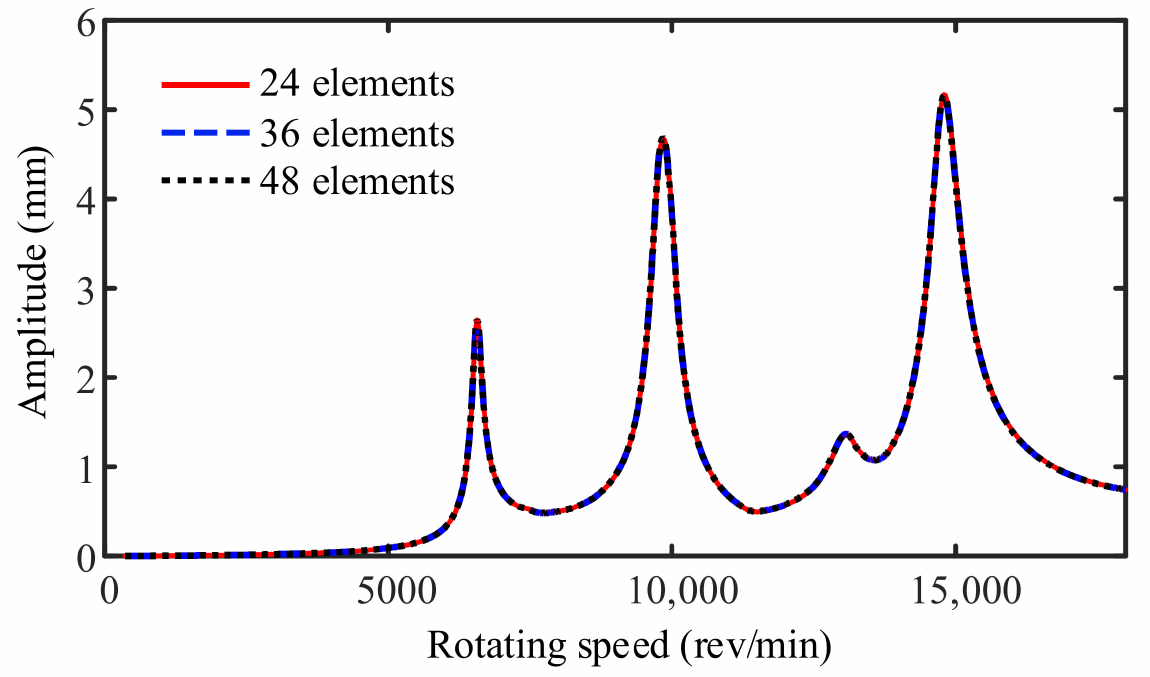
Figure 4. Amplitude frequency responses for 24, 36, and 48